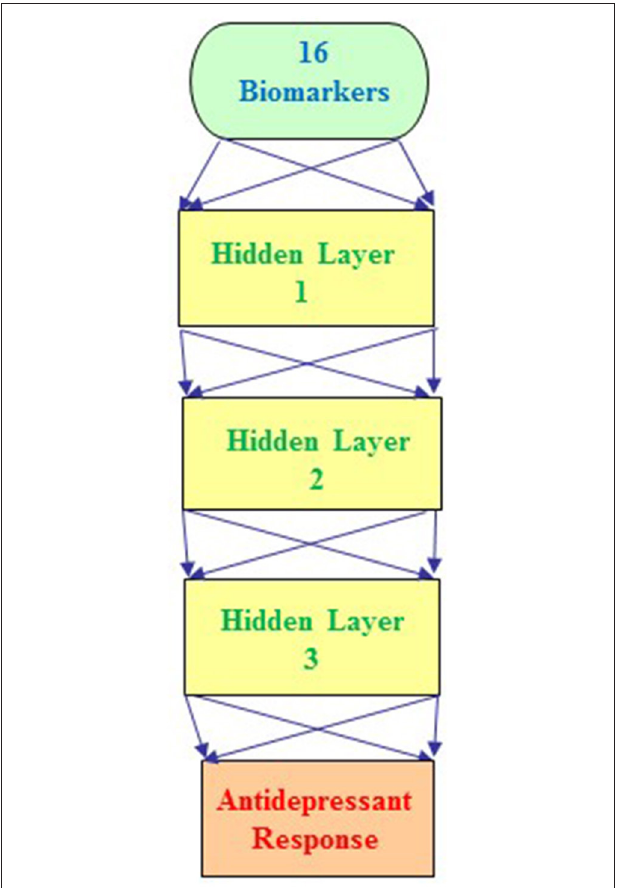
FIGURE 1 | An example architecture of a multilayer feedforward neural network (MFNN) model with 3 hidden layers . The MFNN model contains 16 units in the input layer corresponding to 16 biomarkers (including 10 SNPs and 6 clinical predictors). The MFNN model is configured with 2 units in the output layer corresponding to antidepressant treatment outcome (that is, antidepressant treatment responders and